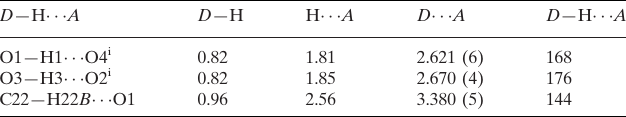
Hydrogen-bond geometry (A˚ , (cid:5)